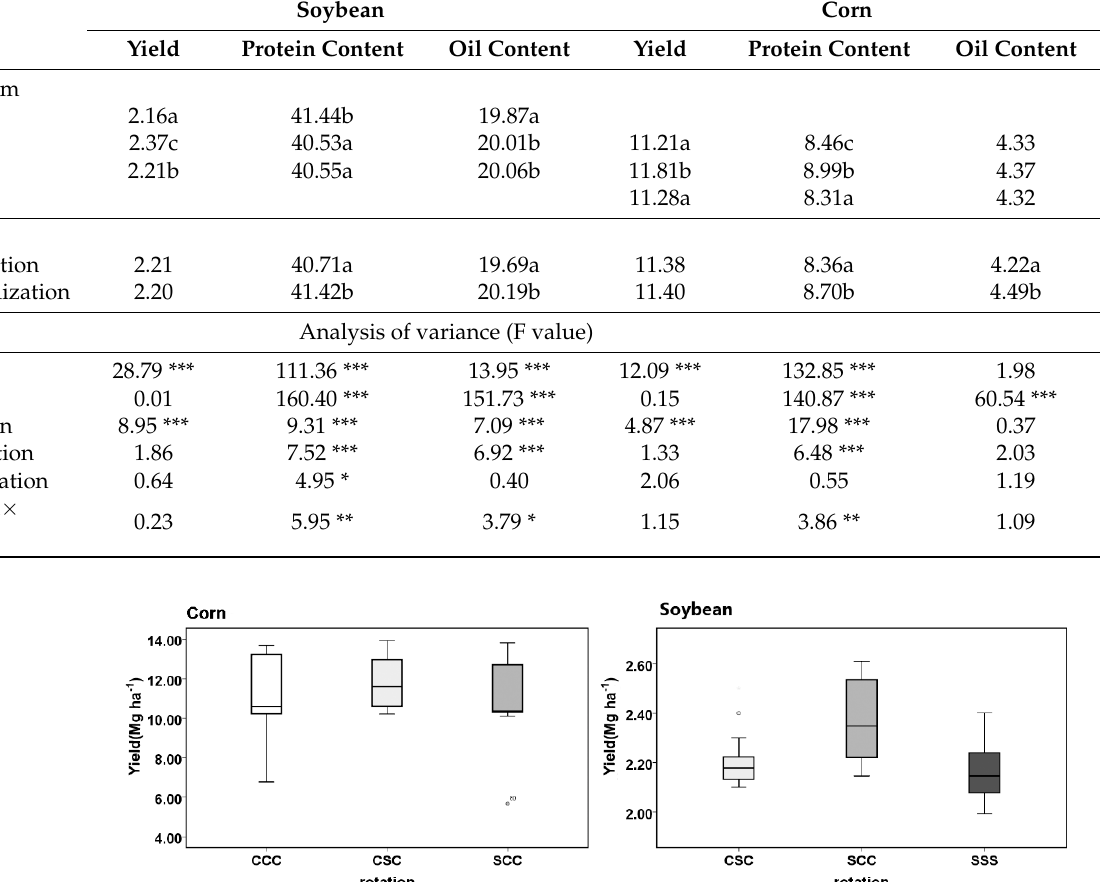
Figure 2. Relationship between yield and plant height (PH) or length of corn ear (LE) for corn. Re- lationship between yield and plant height (PH) or hundred grain weight (HW) for soybean. Differ- ent lowercase letters indicate significant differences at p < 0.05 using Fisher’s least signifi-cant dif- ference. Our study detected significant differences in the protein content of corn among dif- ferent crop sequences but no significant differences in oil content. The protein content of corn ranged from 8.31% to 8.99%, whereas a change tendency of protein content, which was CCC ˂ SCC ˂ CSC, was found among crop sequences (Table 2). Significant differences were found in the sequence of SSS compared to the sequences of SCC and CSC for both protein and oil content in soybean (Figure 3). Protein content was the highest (41.44%) and oil content (19.87%) the lowest for soybean in SSS among different crop sequences (Table 2).